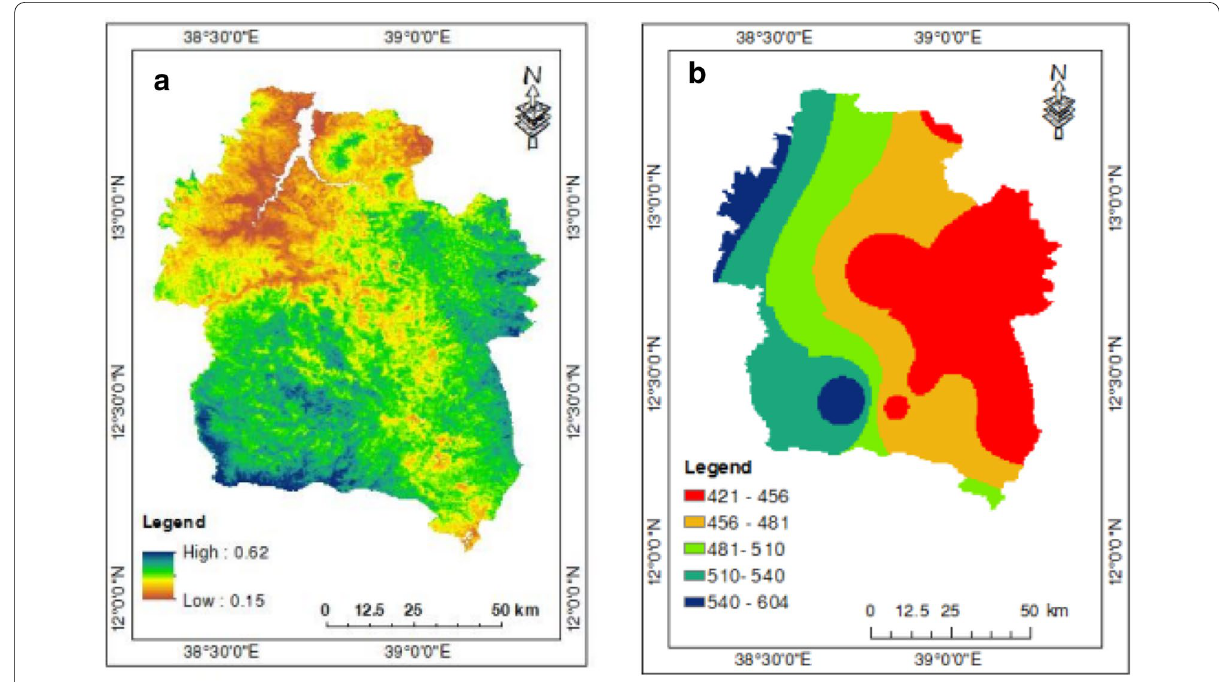
Fig. 6 Spatial pattern of long term seasonal (June to September) NDVI ( a ) and rainfall ( b )